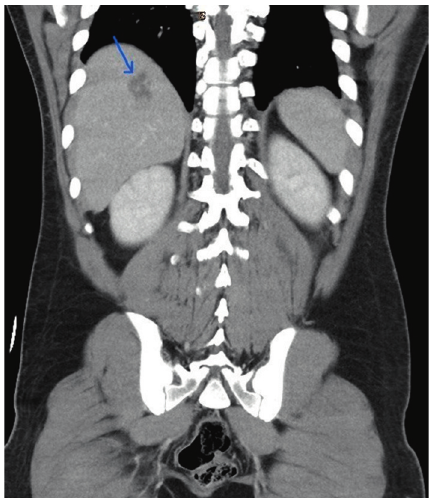
Figure 3: C.T. abdomen coronal view revealing the liver abscess.